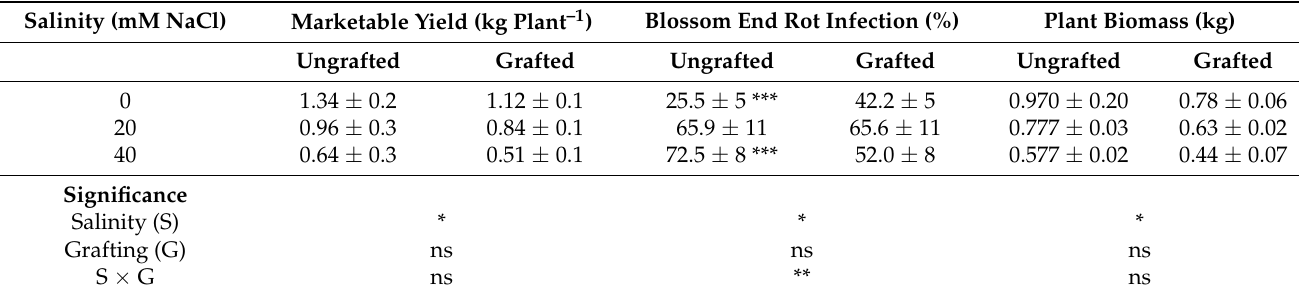
Table 1. Effects of salt stress on marketable yield, blossom end rot infection, and plant biomass for ungrafted and grafted pepper plants, and their salinity and grafting interactions. Salinity (mM NaCl) Marketable Yield (kg Plant –1 ) Blossom End Rot Infection (%) Plant Biomass (kg) Ungrafted Grafted Ungrafted Grafted